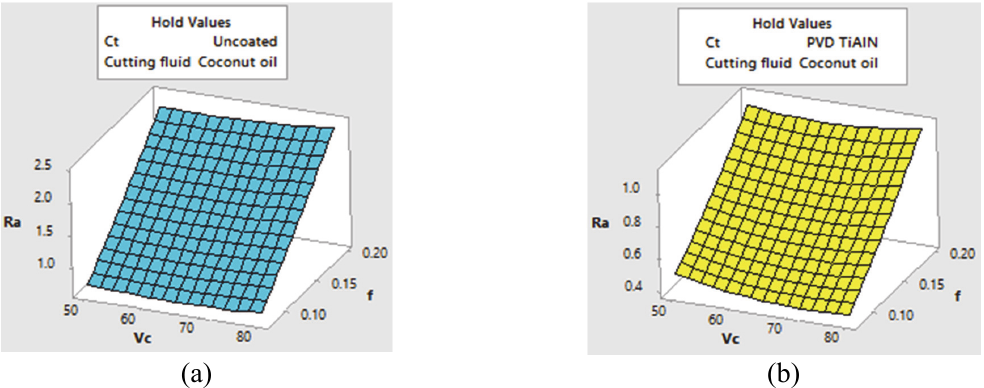
Fig. 8. Surface plot of Ra in MQL enivironment (Coconut oil ) (a) Unoated (b) PVD TiAlN